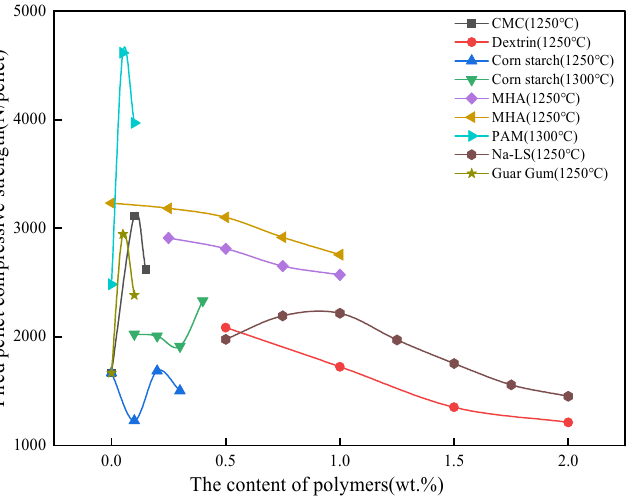
Figure 9. The effect of organic polymers on the fired pellet compressive strength [54,55,60,100,102–104]. The oxidation and recrystallization of Fe 3 O 4 is an important process to improve the fired pellet strength. In a fully oxidized atmosphere, adding an appropriate amount of organic matter can produce a certain number of pores inside the pellets, which is conducive to the full diffusion of O 2 into magnetite pellets to oxidize Fe 3 O 4 into the primary crystal of Fe 2 O 3 , as shown in Figure 10a. At the same time, as the temperature rises, the oxidized Fe 3+ on the surface of the pellet will continue to promote the diffusion of Fe 2 O 3 to the inner layer, and the primary grains of Fe 2 O 3 grow up and get close to each other, and some of the grains will start to connect, gradually forming a Fe 2 O 3 microcrystal connection bridge, as shown in Figure 10b. When the temperature reaches approximately 1250 ◦ C, Fe 2 O 3 crystals grow up again, and the grains are interconnected to form interconnected crystals, resulting in the formation of a dense structure inside the pellets, as shown in Figure 10c. The recrystallization process of the Fe 2 O 3 crystal can be improved by roasting at the optimum temperature for enough time, and the fired pellet strength can be greatly improved. For hematite pellets, only when the temperature is high enough, do the Fe 2 O 3 grains begin to recrystallize and grow up, forming a certain strength. However, such a recrystallization bond is not as strong as the recrystallization strength of Fe 3 O 4 oxidized to Fe 2 O 3 [105]. When the temperature rises above 1300 ◦ C, the primary hematite will decompose and decrease in